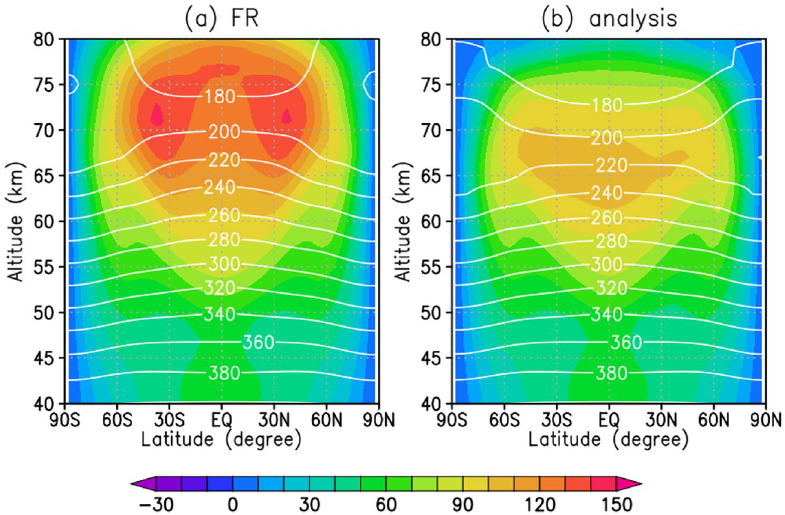
Figure 4. Latitudinal and vertical distributions of temporal and zonal-mean zonal wind (colour, m s −1 ) and temperature (contour, K) averaged in two Earth months: ( a ) FR and ( b )